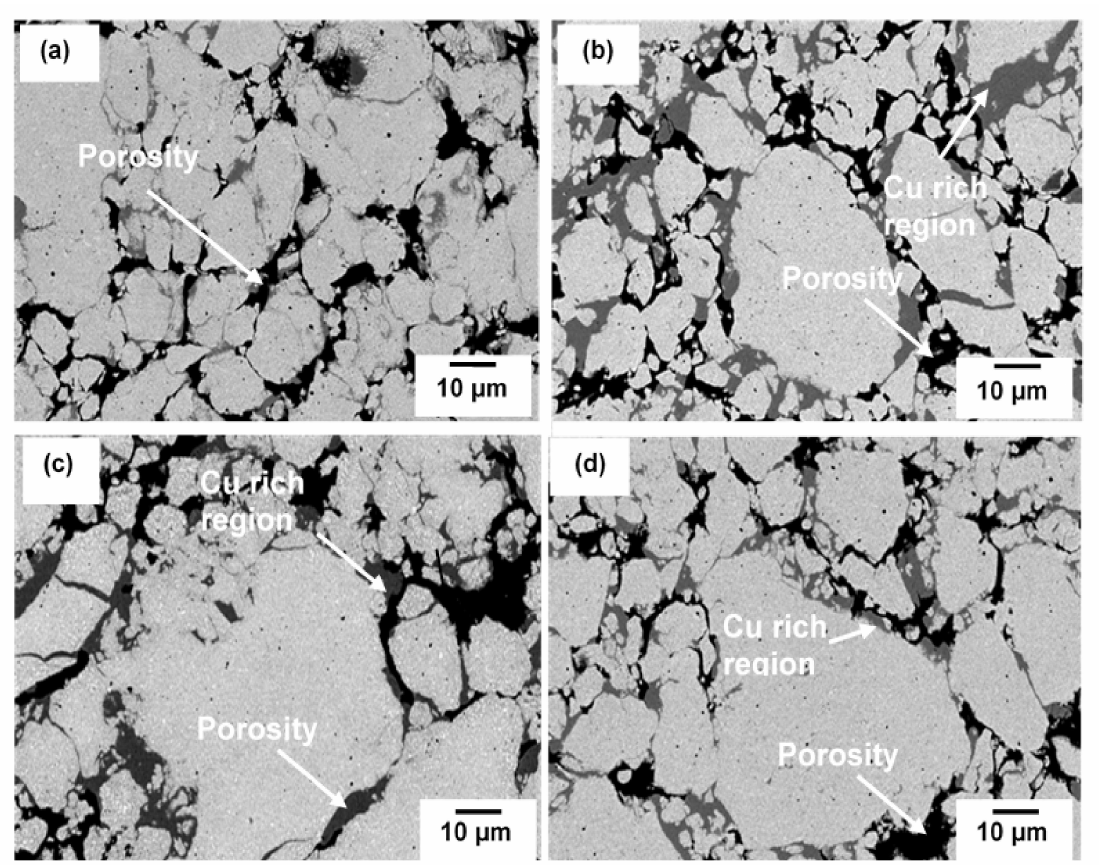
Figure 11. SEM images of Cu-W-C sintered composite milled at ( a ) 10 h, ( b ) 20 h, ( c ) 40 h and ( d ) 60